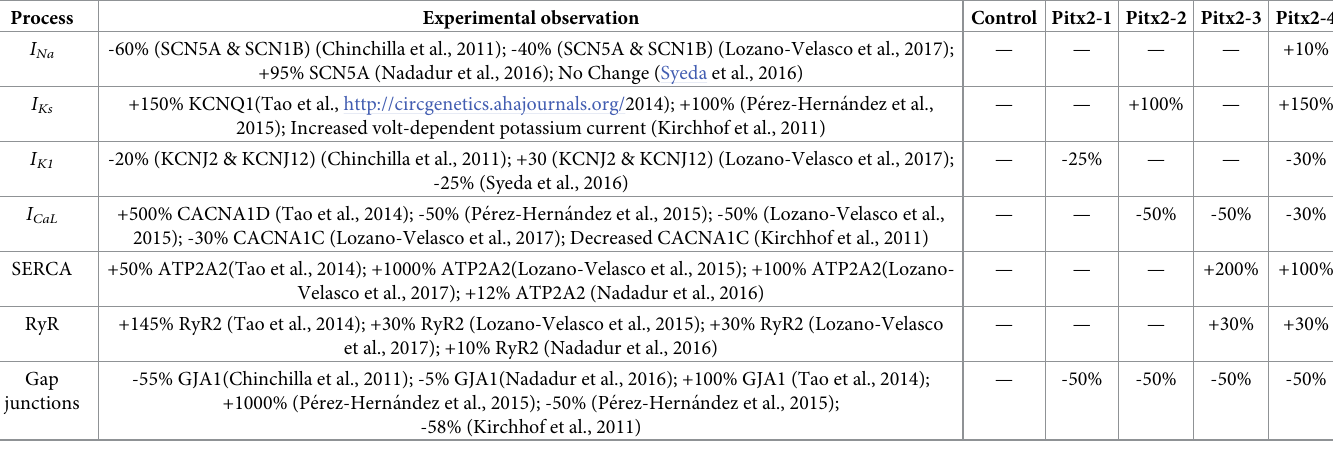
Table 1. Review of Pitx2-insufficiency induced remodelling data and model parameters in human left atrium.